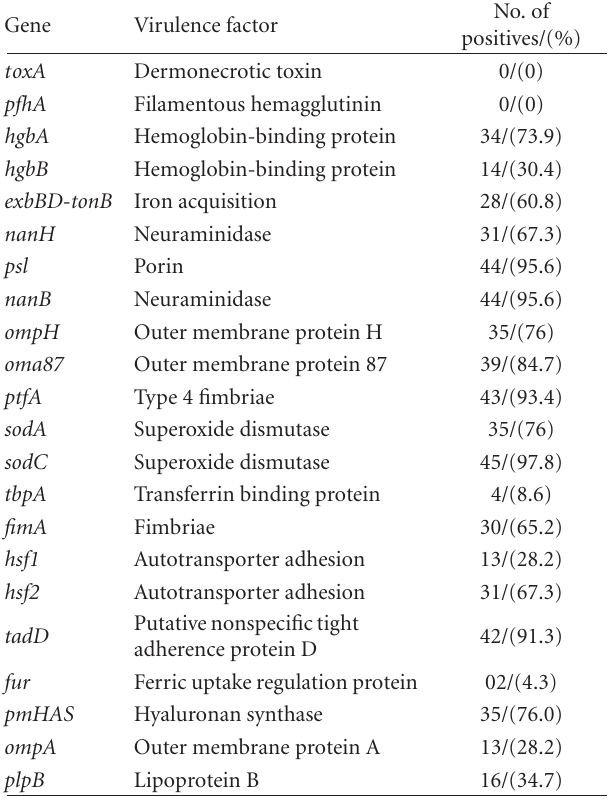
Table 2: Frequency of protein-coding genes and virulence factors in P. multocida strains isolated from